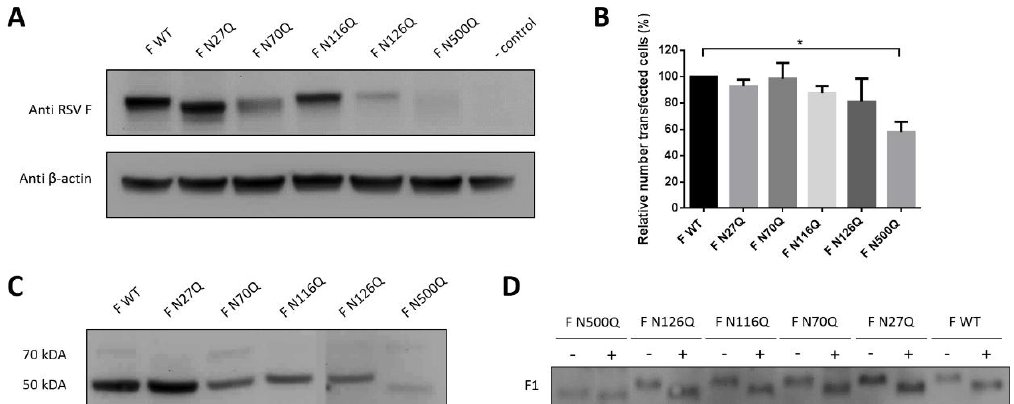
Figure 1. Expression analysis of recombinant respiratory syncytial virus (RSV) F proteins. BSR T7/5 cells were transfected with pCAXL encoding RSV F glycosylation mutants. Cells were lysed and proteins were separated by SDS page or cells were analysed by immunofluorescence staining. ( A ) Proteins were separated under non-reducing conditions and Western blot was developed with palivizumab and anti-actin IgG. ( B ) Cells were stained with palivizumab and AF488-conjugated goat anti-human IgG to determine the relative number of transfected cells (%). Data represents the mean ( ± SD) of three independent repeats * p < 0.05 (Student’s unpaired two-tailed t test). ( C , D ) Cell lysates were separated under reduced conditions in panel C and treated with PNGase F (+) or left untreated ( − ) for 2 h at 37 ◦ C in panel D. Western blots were probed with palivizumab.